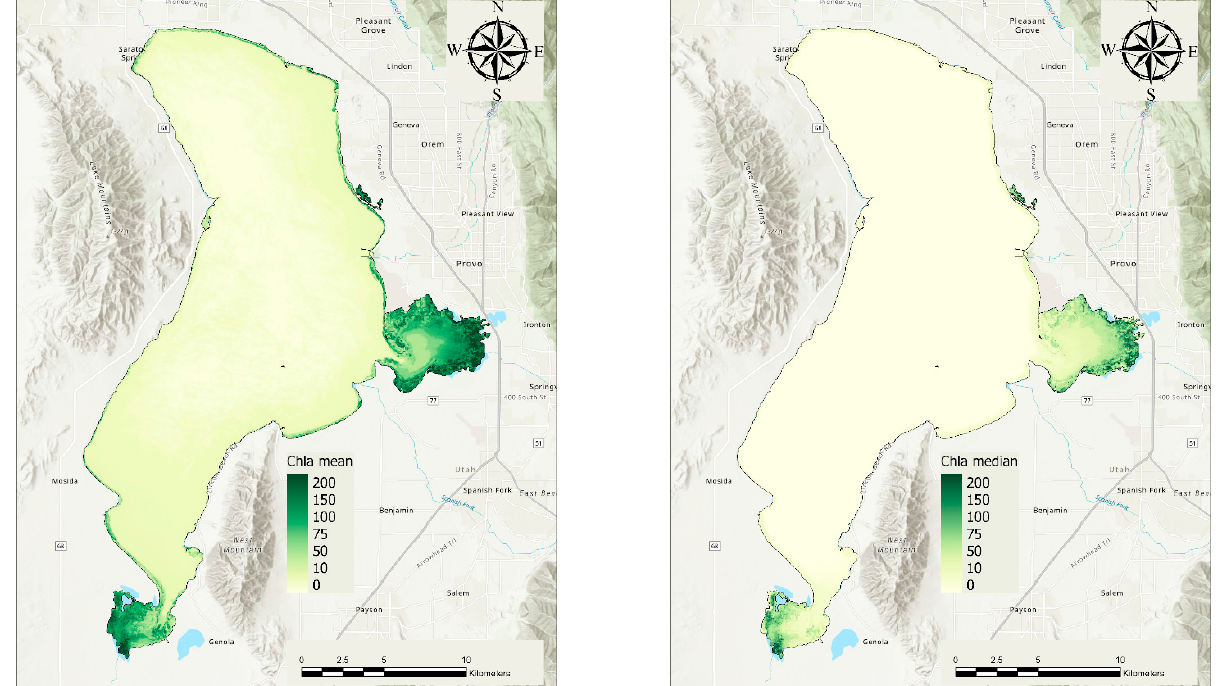
Figure 6. Mean ( left ) and median ( right ) average chl-a concentrations over the ~40-year study period. A non-linear color scale was selected to highlight lower concentration ranges in order to show the differences in the middle lake area, since concentrations outside of the two shallow bays are comparatively low.